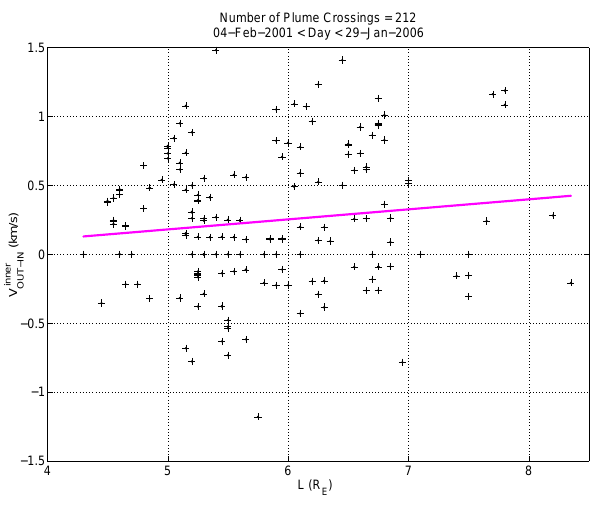
Fig. 15. Characteristics of the plumes observed by the same satellite in the inbound and outbound plasmasphere passes: apparent radial of the inner boundary of a plume crossed in both velocity V inner out − in hemispheres. This velocity is plotted as a function of the average L at which the inner plume boundary is observed in the inbound and outbound crossings. The magenta curve gives a linear least-square fit of this